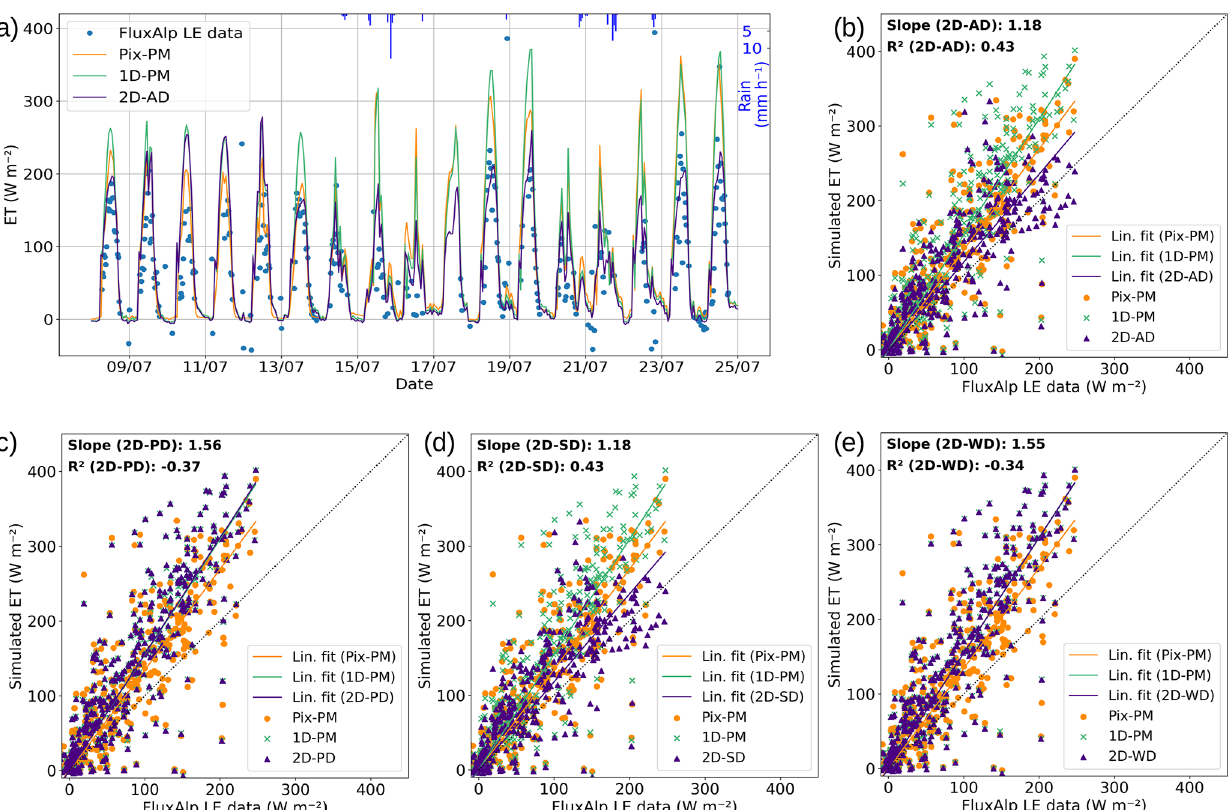
Figure 7. (a) Evapotranspiration simulation masked with a wind direction mask for 17d in summer for the all distributed run (2D-AD). Scatter plot for the July to August 2018 period for (b) the all distributed run (2D-AD), (c) the only precipitation distributed run (2D-PD), (d) the only shortwave radiation distributed run (2D-SD), and (e) the only wind speed distributed run (2D-WD). Each slope line represents the corresponding linear fit to the scatter plot; the slope value of each simulation is highlighted at the